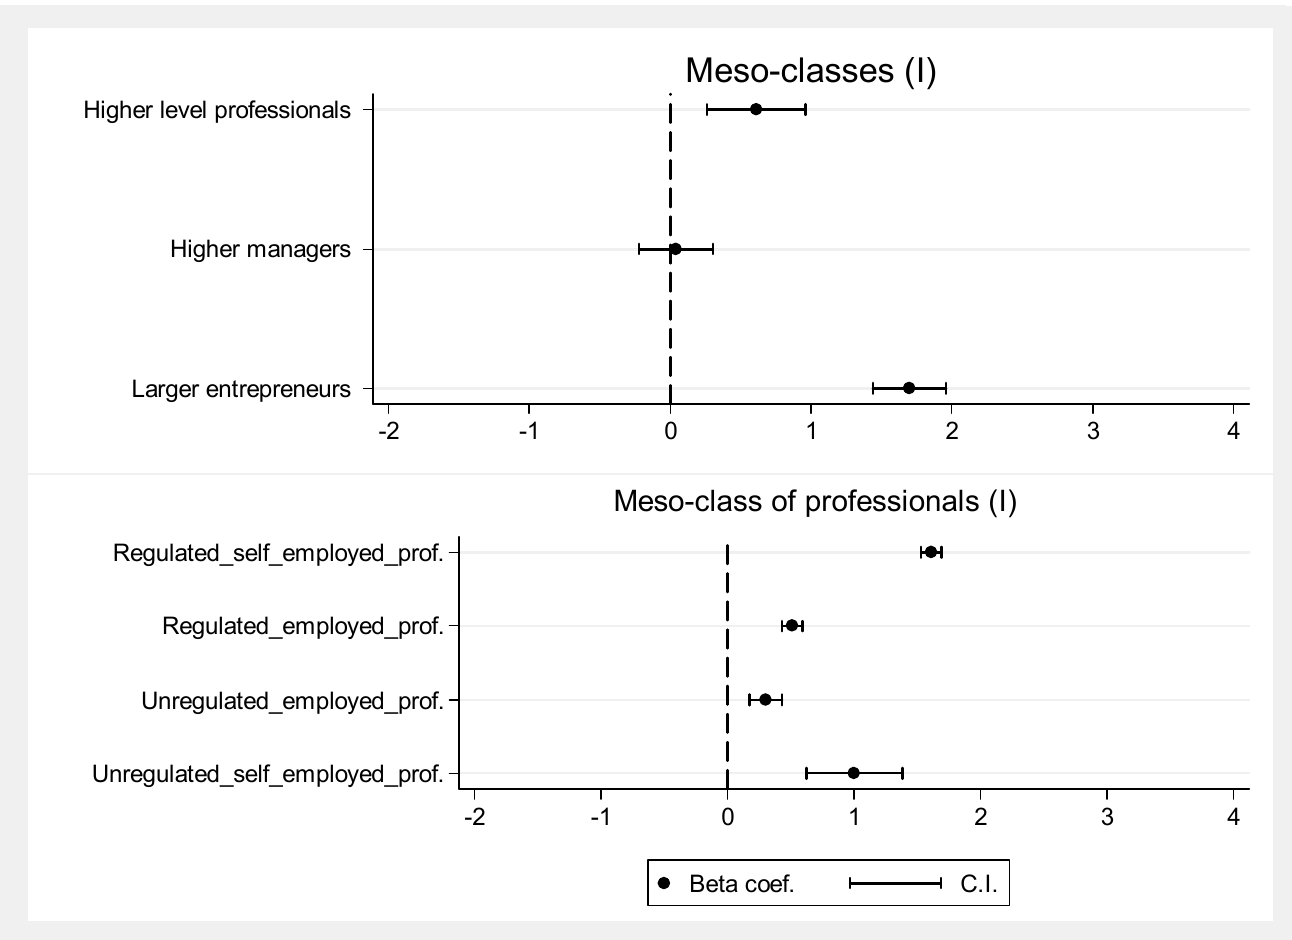
Figure 3. Beta parameters for social immobility for meso-classes and the additional interaction between self-employment and regulation at meso-level. Beta parameters with confidence intervals from Models 2a and 6a.